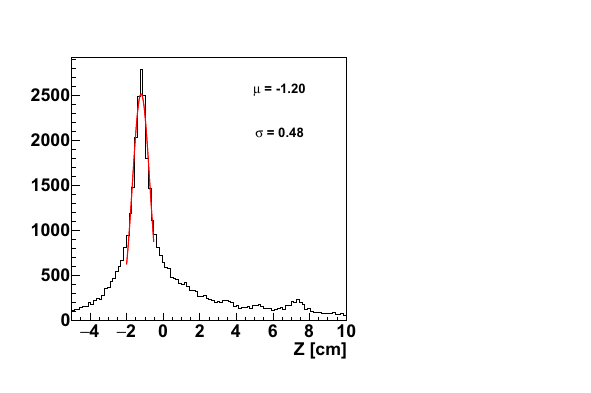
Positions of some trigger detectors (BC3 and Si trigger) are distinguished better after the alignment